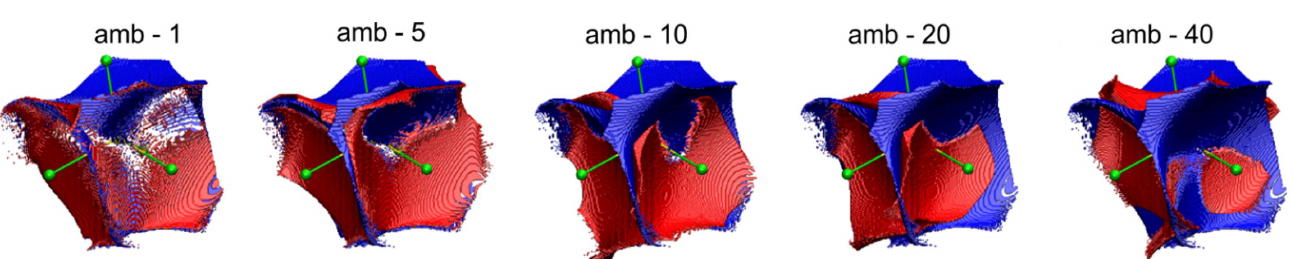
Figure 10 Differences between shape of the sulfur atomic basin (in blue) at ambient pressure and pressures ranging from 1 to 40 GPa (in red).